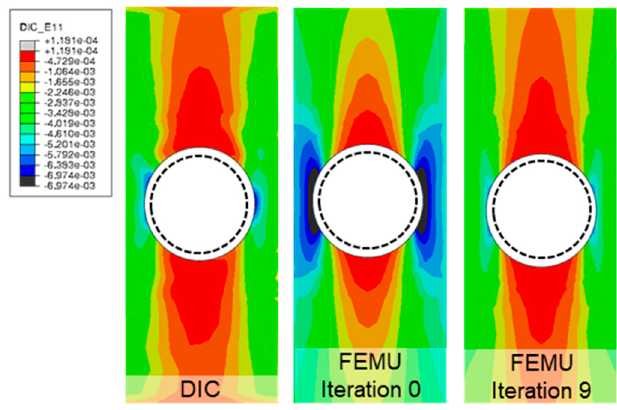
Figure 12. Comparison of DIC-measured longitudinal strains with FE results from the OHC-ILT FEMU procedure before (iteration 0) and after optimization (iteration 9) of material parameters.